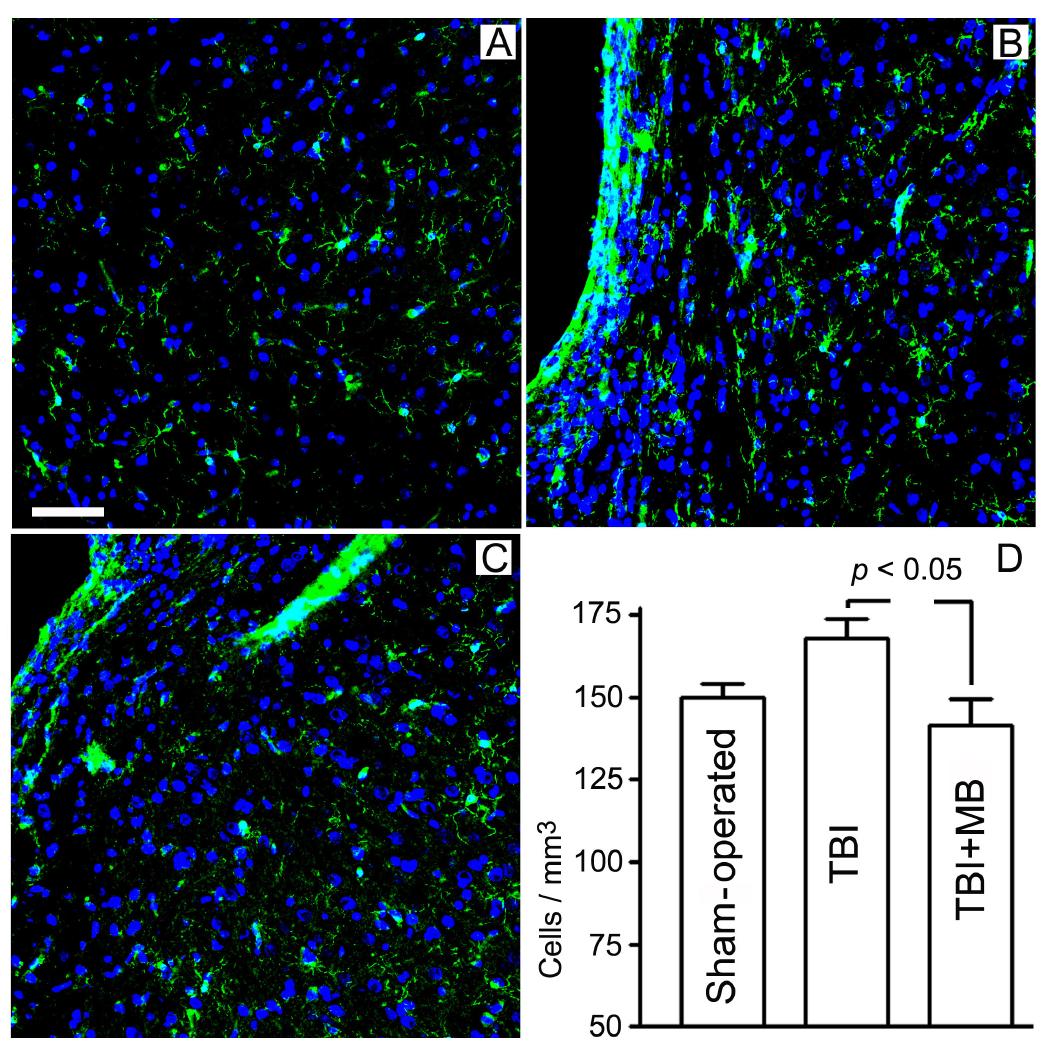
Figure 4. E ff ect of methylene blue (MB) on the microglial expression in rat cerebral cortex (ipsilateral hemisphere). The 180th day after traumatic brain injury (TBI). Administration of methylene blue 30 min after the injury and then monthly (6 injections in total). ( A – C )—immunohistochemical staining of microglial cells in ipsilateral hemisphere (green fluorescence). The cell nuclei fluoresce blue (DAPI). ( A )—sham-operated animals; ( B )—animals treated with saline solution after TBI; ( C )—TBI + MB. Scale bar, 0.05 mm; ( D )—quantitative evaluation of microglial density.